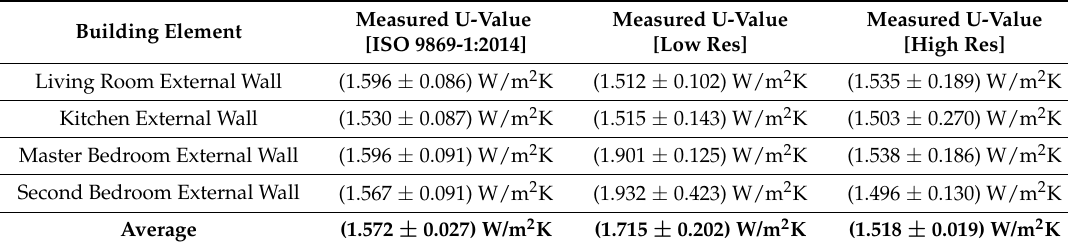
Table 3. Comparison of mean measured U-values for external walls of the energy